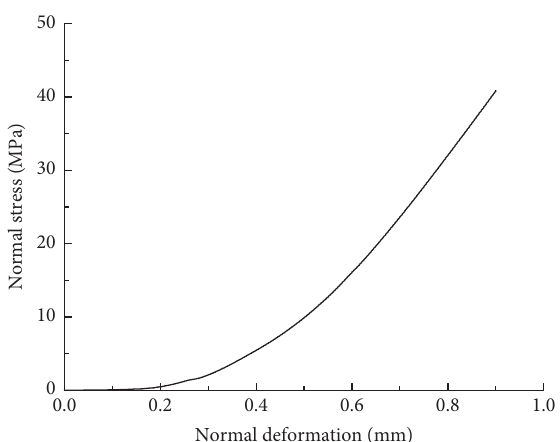
Figure 10: Normal stress and deformation curve of the joint simulation